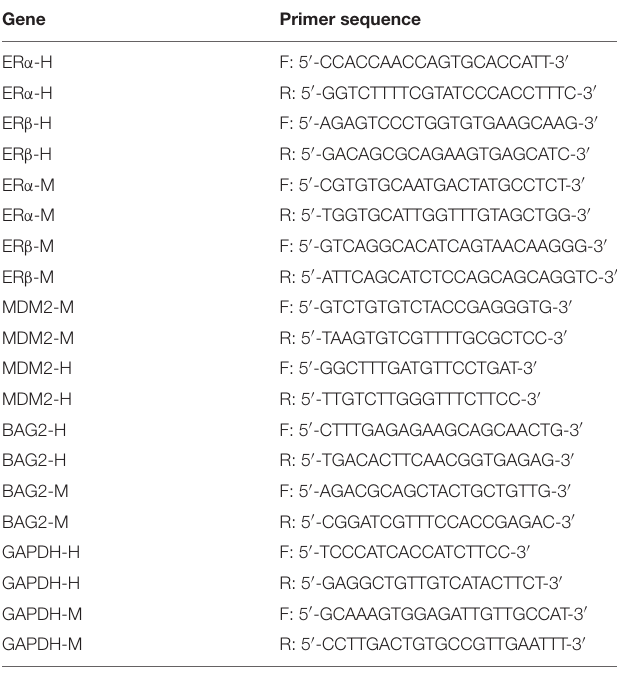
TABLE 1 | Primer sequences of related genes for